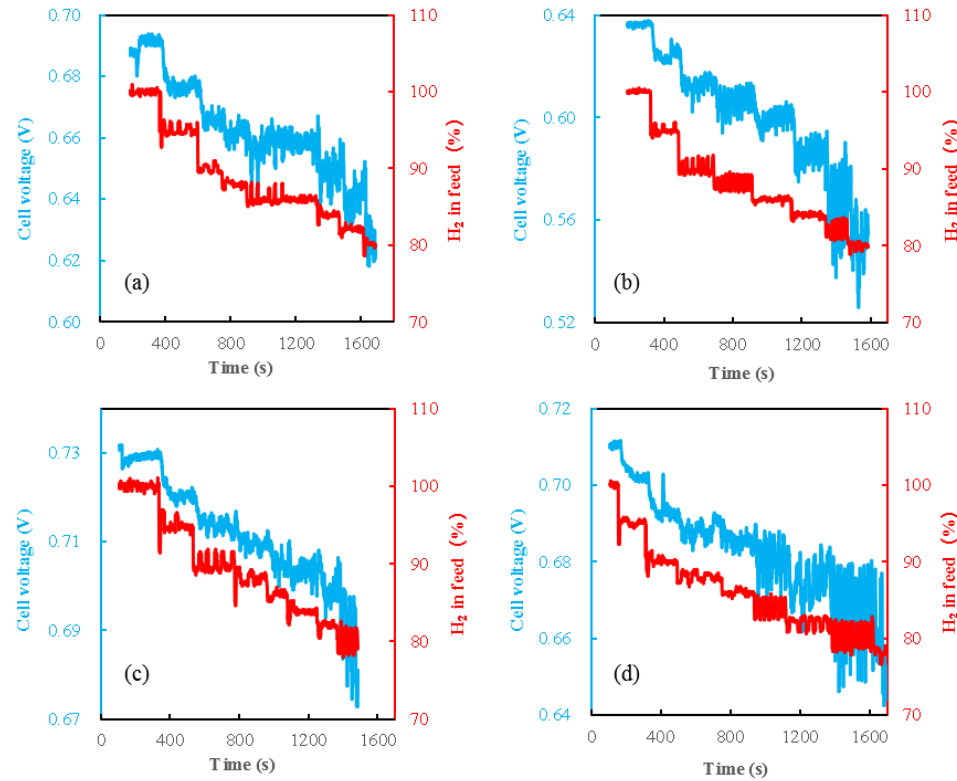
Figure 6. Test results of cell 11 at different current densities: ( a ) 0.2 A ∙ cm − 2 ; ( b ) 0.6 A ∙ cm − 2 ; ( c ) 1.0 A ∙ cm − 2 ; ( d ) 1.4 A ∙ cm − 2 .